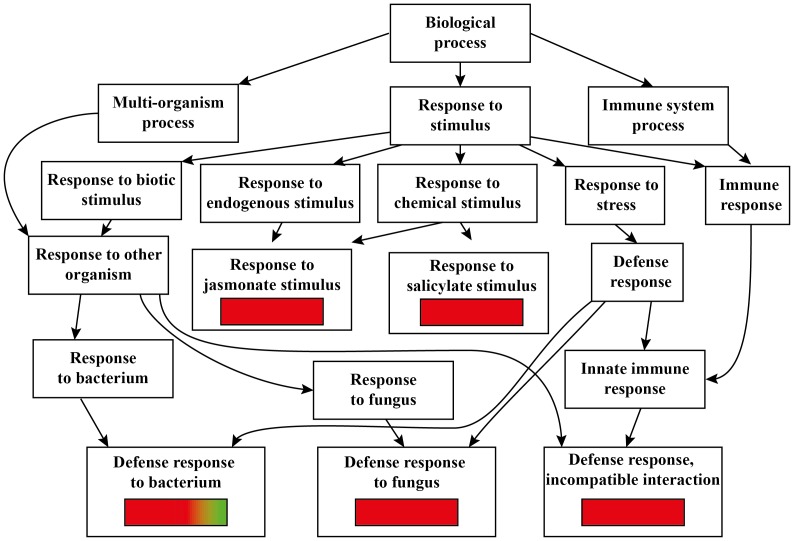
GO analysis of Arabidopsis genes regulated by Pseudomonas syringae infection.Red color indicates up-regulation, green color indicates down-regulation.